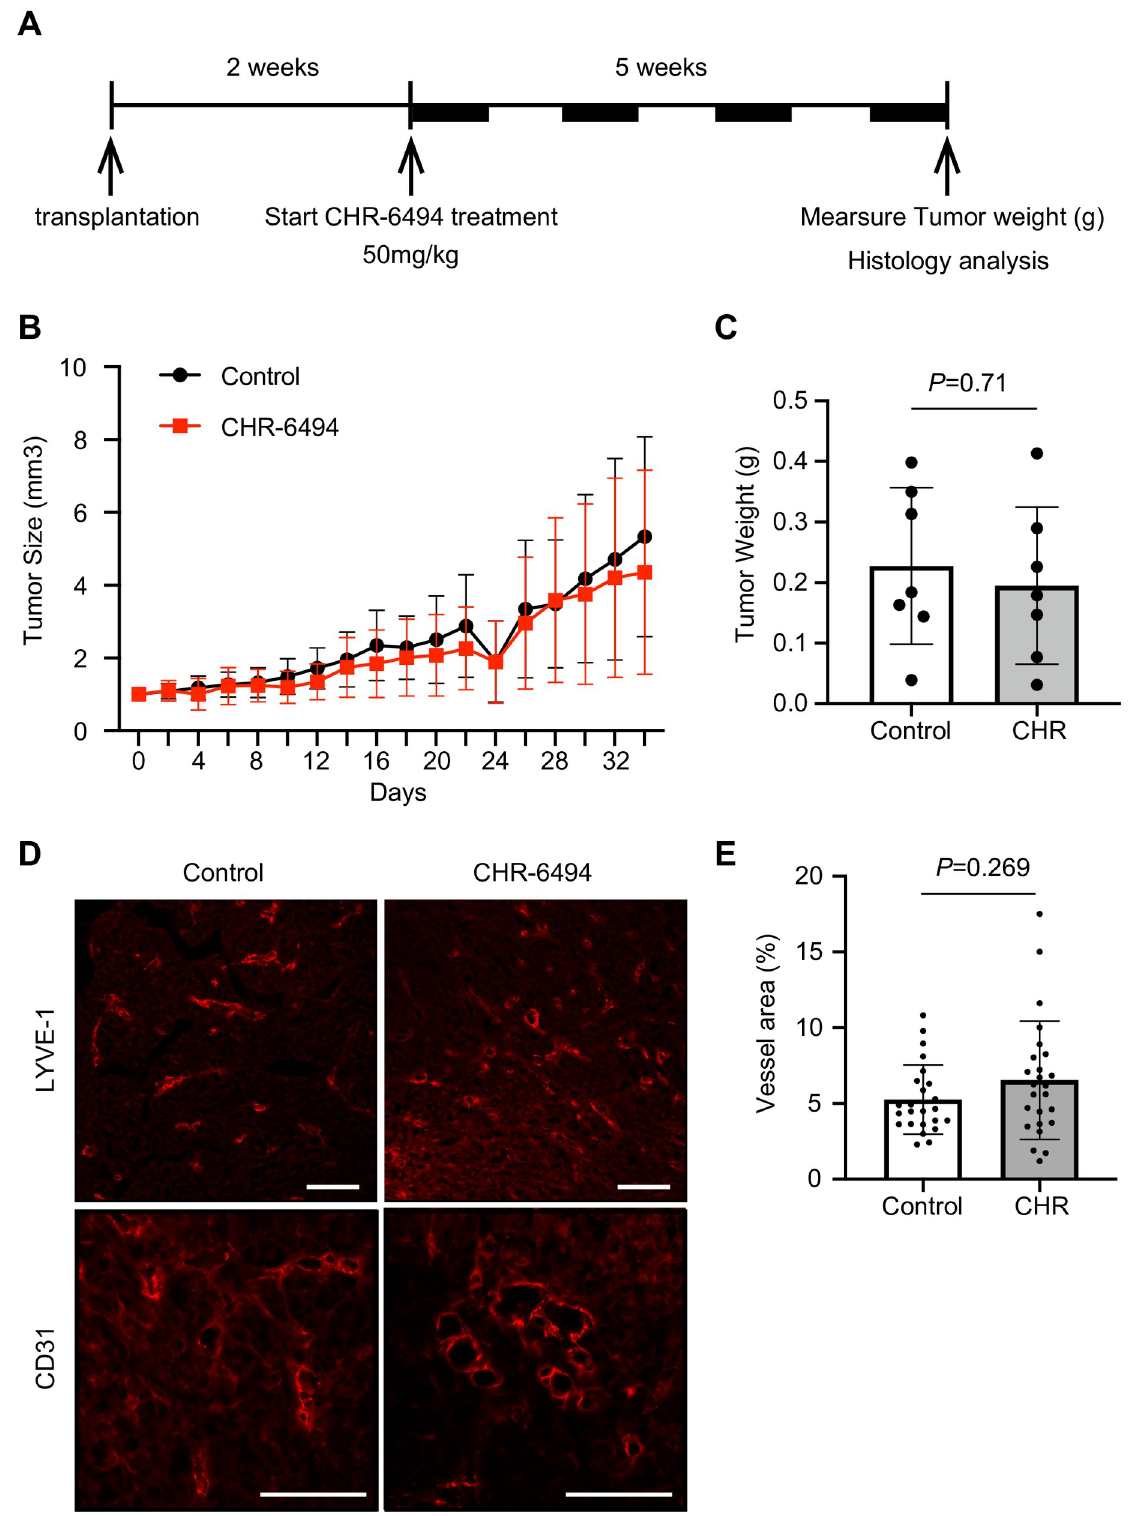
Fig 4. Effects of CHR-6494 on the growth of MDA-MB-231 xenografts. (A) Schematic representation of CHR-6494 treatment in MDA-MB-231 xenografted mice. Two weeks after MDA-MB-231 transplantation in immunodeficient nude mice, mice received four